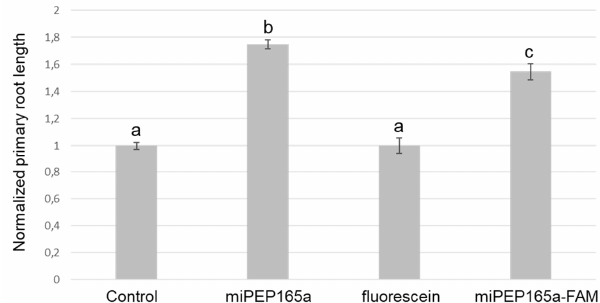
Figure 3. MiPEP165a-FAM is biologically active. Seedlings were treated with water (control), 100 µM miPEP165a, miPEP165a-FAM, or fluorescein. At least 70 seedlings were used to determine the normalized Arabidopsis root length. Data are given as ± SEM and statistical analysis was performed using a t-test (a–c, p < 0.01). Interestingly, while the labelled peptide penetrated rapidly (~2 h) into the root cap and the Int. J. Mol. Sci. 2020 , 21 , x FOR PEER REVIEW meristematic zone, it took longer to penetrate the other parts of the root (Figure 4). Twenty-four hours after the application of the labelled peptide, the latter was present in most external parts of the roots. The central cylinder was never labelled by the peptide, which seemed to be blocked by the pericycle (Figure 4).